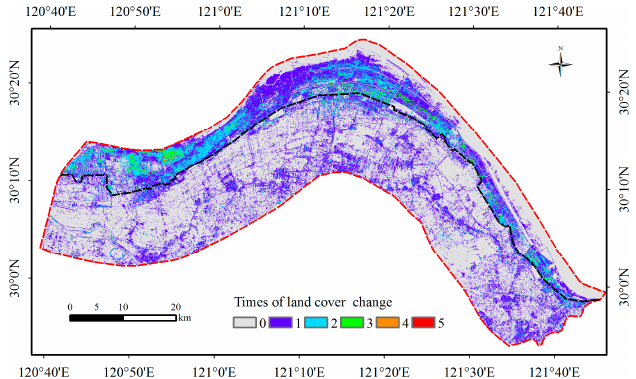
Figure 5. Times of land cover change on the south side of Hangzhou Bay in Zhejiang Province, China (the black dash line represents the coastline in 1984). Table 4. Areas of different change times at Hangzhou Bay in Zhejiang Province, China, between 1987 and 2015.